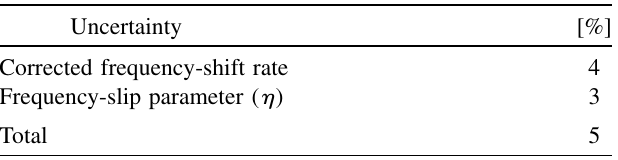
TABLE II. Contributions to the uncertainty in the determina- tion of the effective target thickness from the beam-energy losses. The total uncertainty has been obtained by adding these elements quadratically.